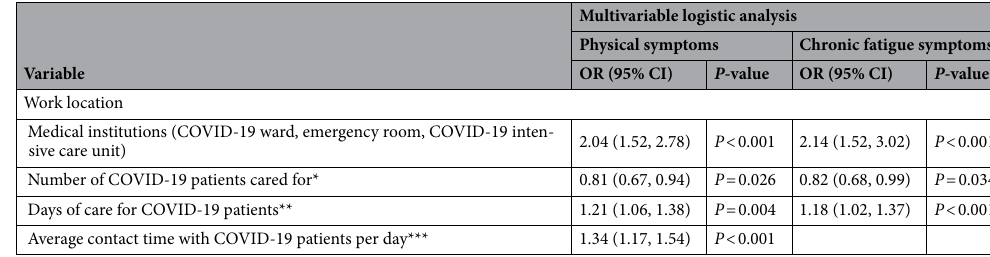
Table 8. Multivariable logistic regression analysis of physical (PHQ-15 ≥ 10) and chronic fatigue (FSS ≥ 3.22) symptoms after the COVID-19 outbreak according to patient care work. CI confidence interval. *0, 1–10 patients, 11–20 patients, more than 20 patients, as the number of patients to care increases from a small group to a large group. **0, 1–29 days, 30–59 days, 60–89 days, more than 90 days, as the number of days of care for COVID-19 patients increases from a small group to a large group. ***No, less than 30 min, 30 min–2 h, 2–6 h, more than 6 h, as the contact time with COVID-19 patients per day increases from a small group to a large